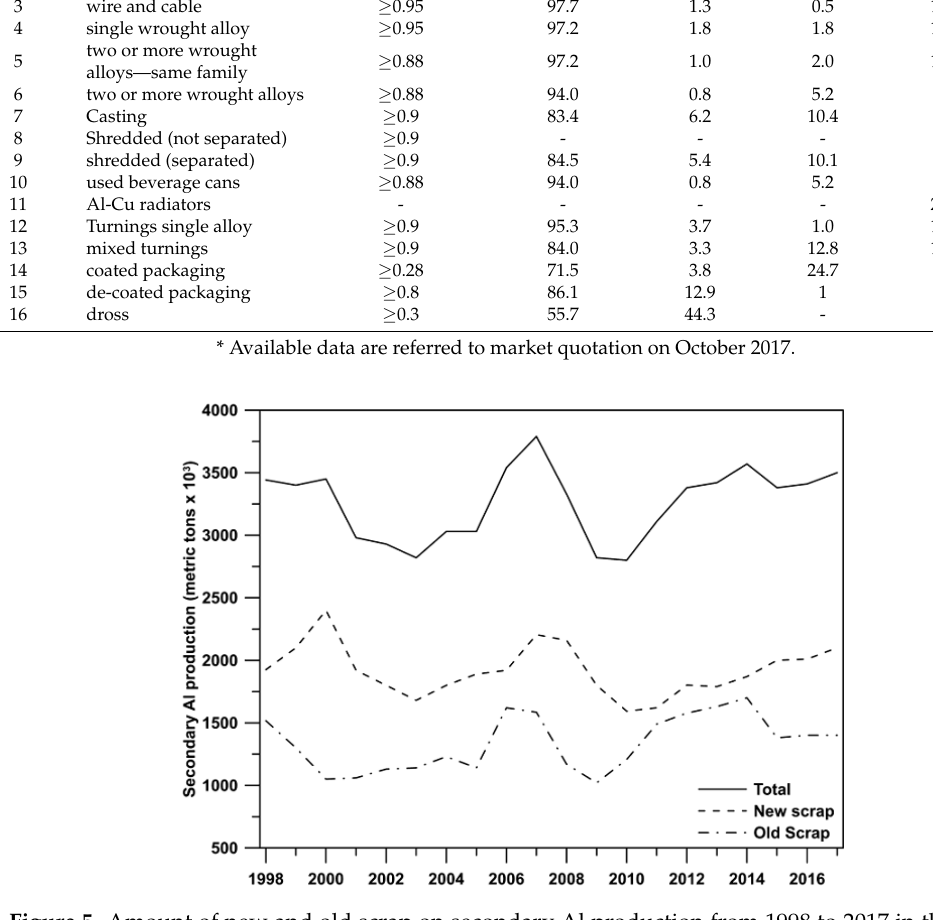
Figure 5. Amount of new and old scrap on secondary Al production from 1998 to 2017 in the USA. Data elaborated from